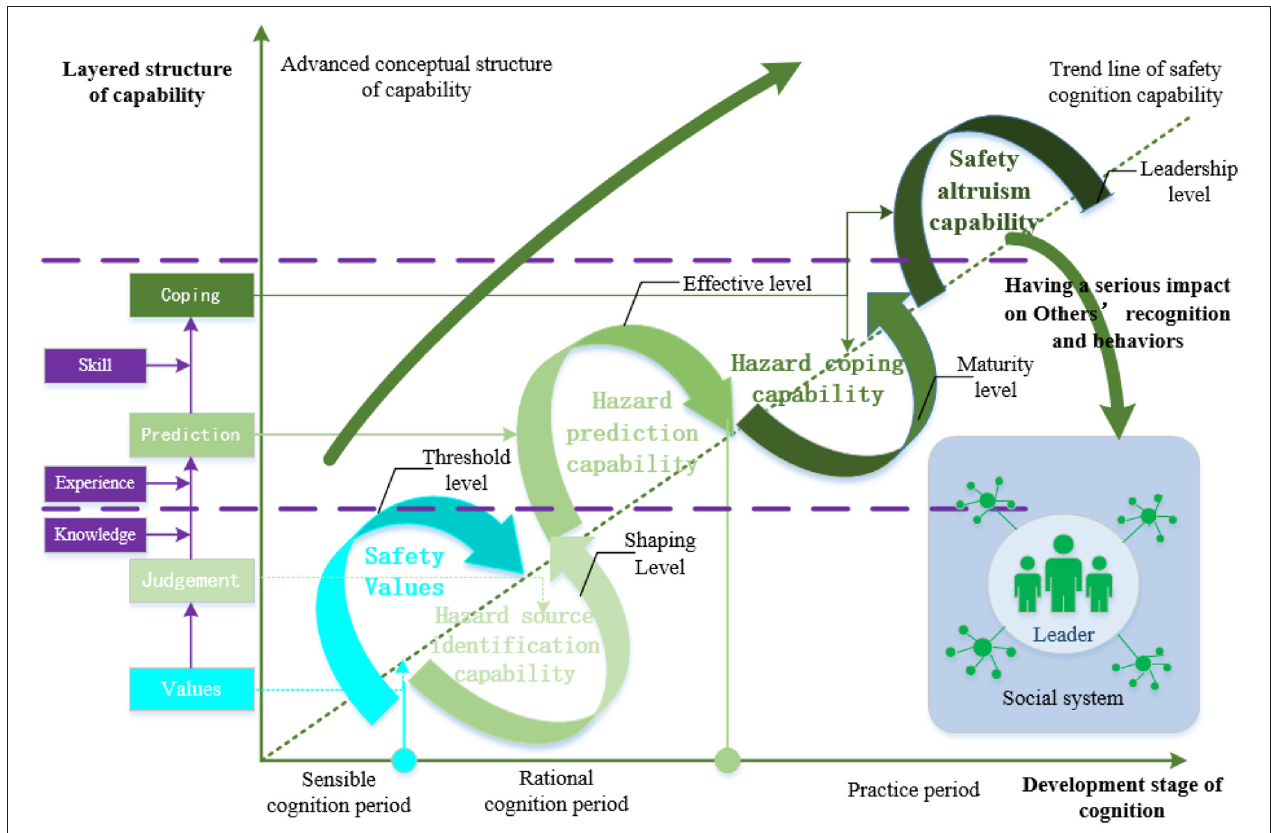
FIGURE 1 | Conceptual structure of safety cognition capability in the whole